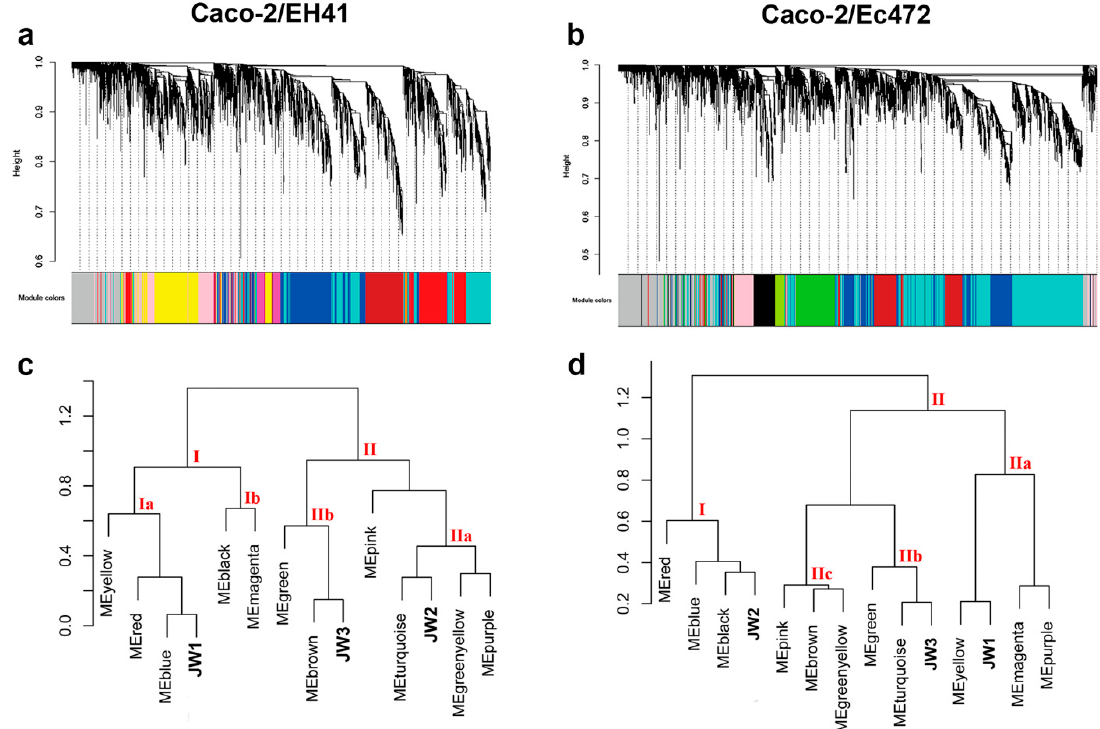
Figure 5. WGCNA for Caco-2 / EH41 and Caco-2 / Ec472 groups. Hierarchical clustering dendrogram and module identification, indicated by di ff erent colors, for Caco-2 / EH41 ( a ) and Caco-2 / Ec472 ( b ). Eigengene module dendrogram obtained for Caco-2 / EH41 ( c ) and for Caco-2 / Ec472 ( d ). Red roman numbers indicate the major meta-modules.